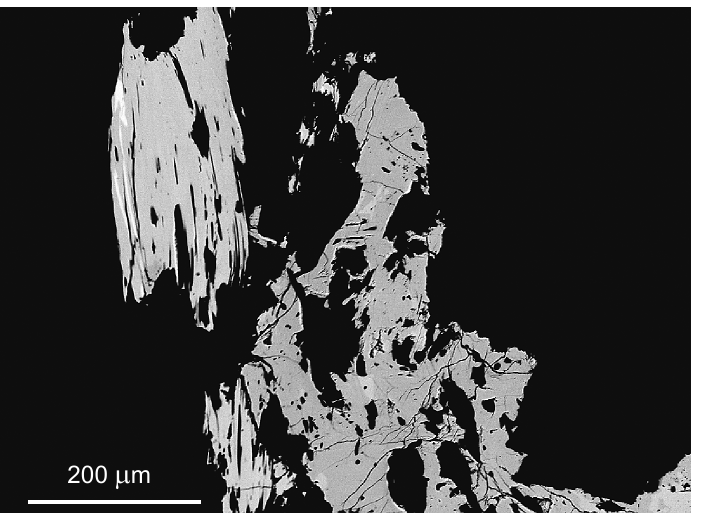
Figure 13. Chovanite aggregates (light grey) with relics of boulangerite (white) in association with rouxelite (dark grey). BSE photo.